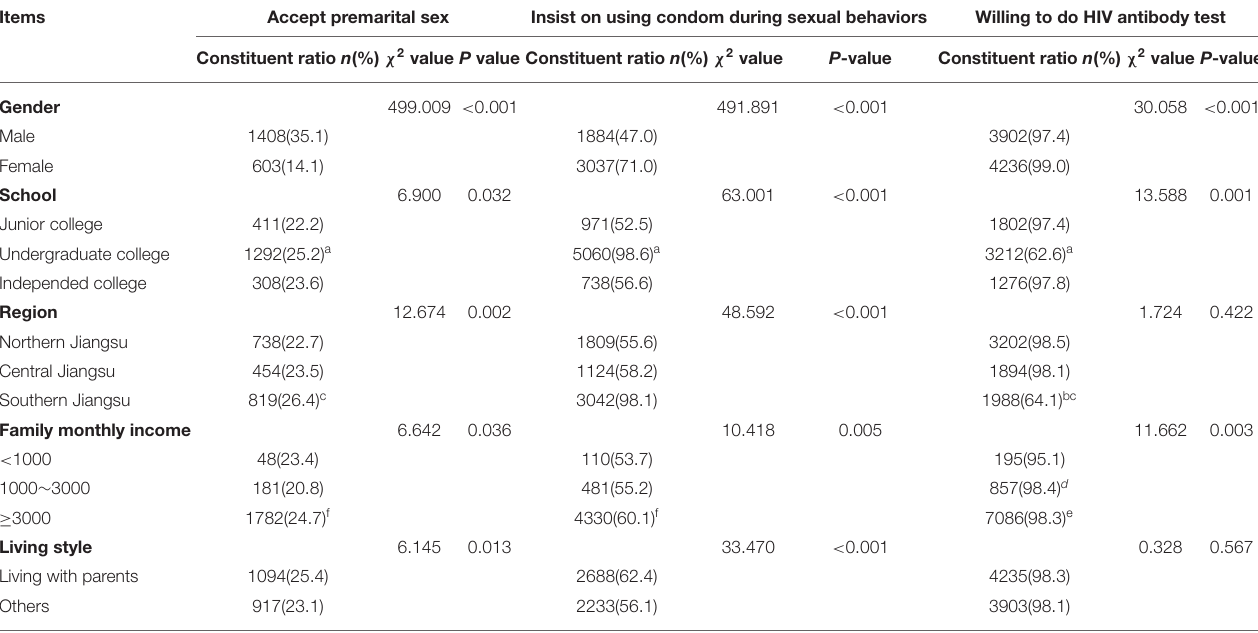
TABLE 3 | Different demographic characteristics of freshmen attitudes about sexual behaviors.